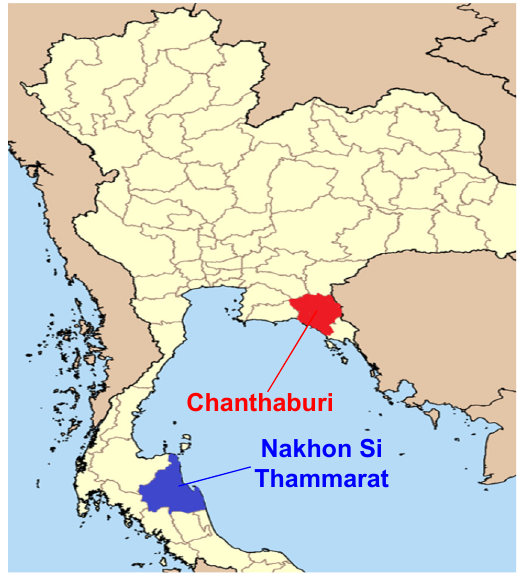
Figure 1. Map of Thailand.